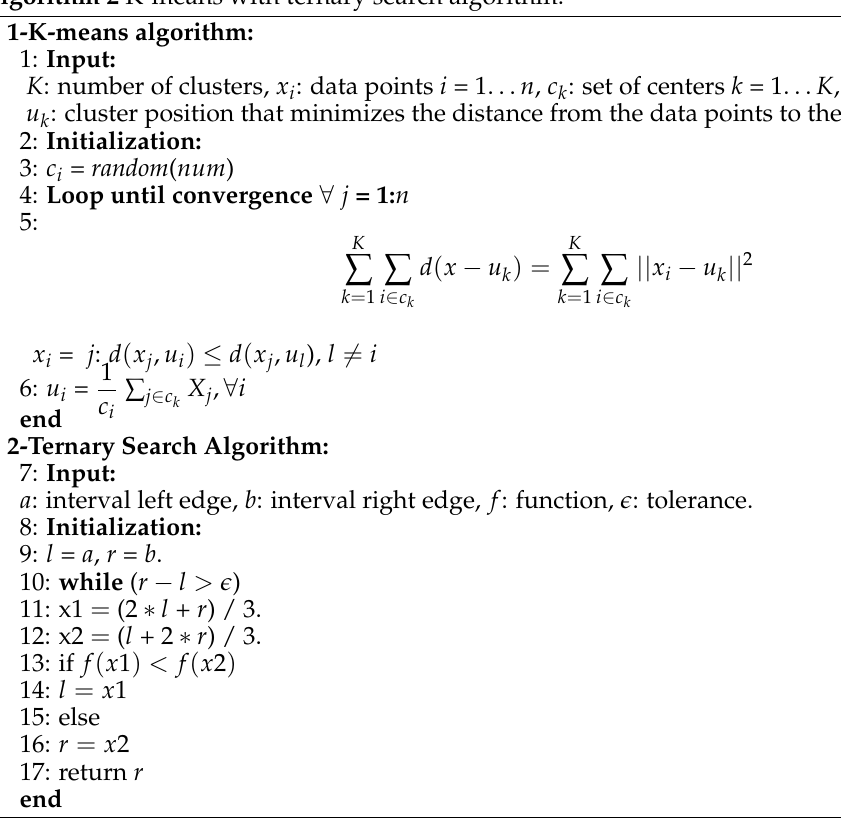
Algorithm 2 K-means with ternary search